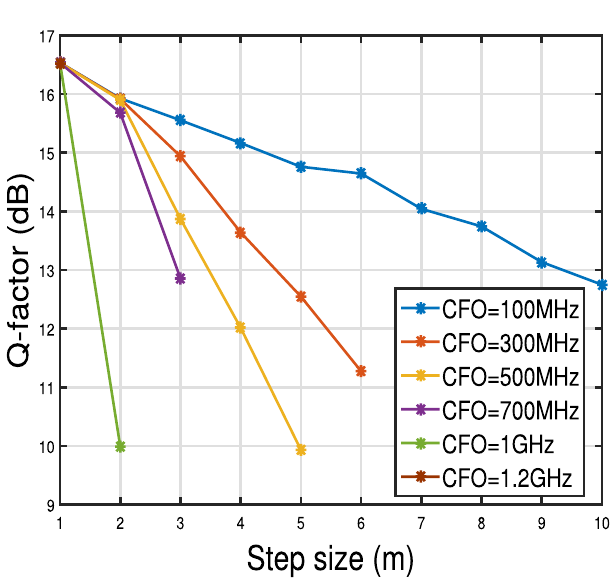
100 kHz and different frequency offsets for Pin = = 3 BER is